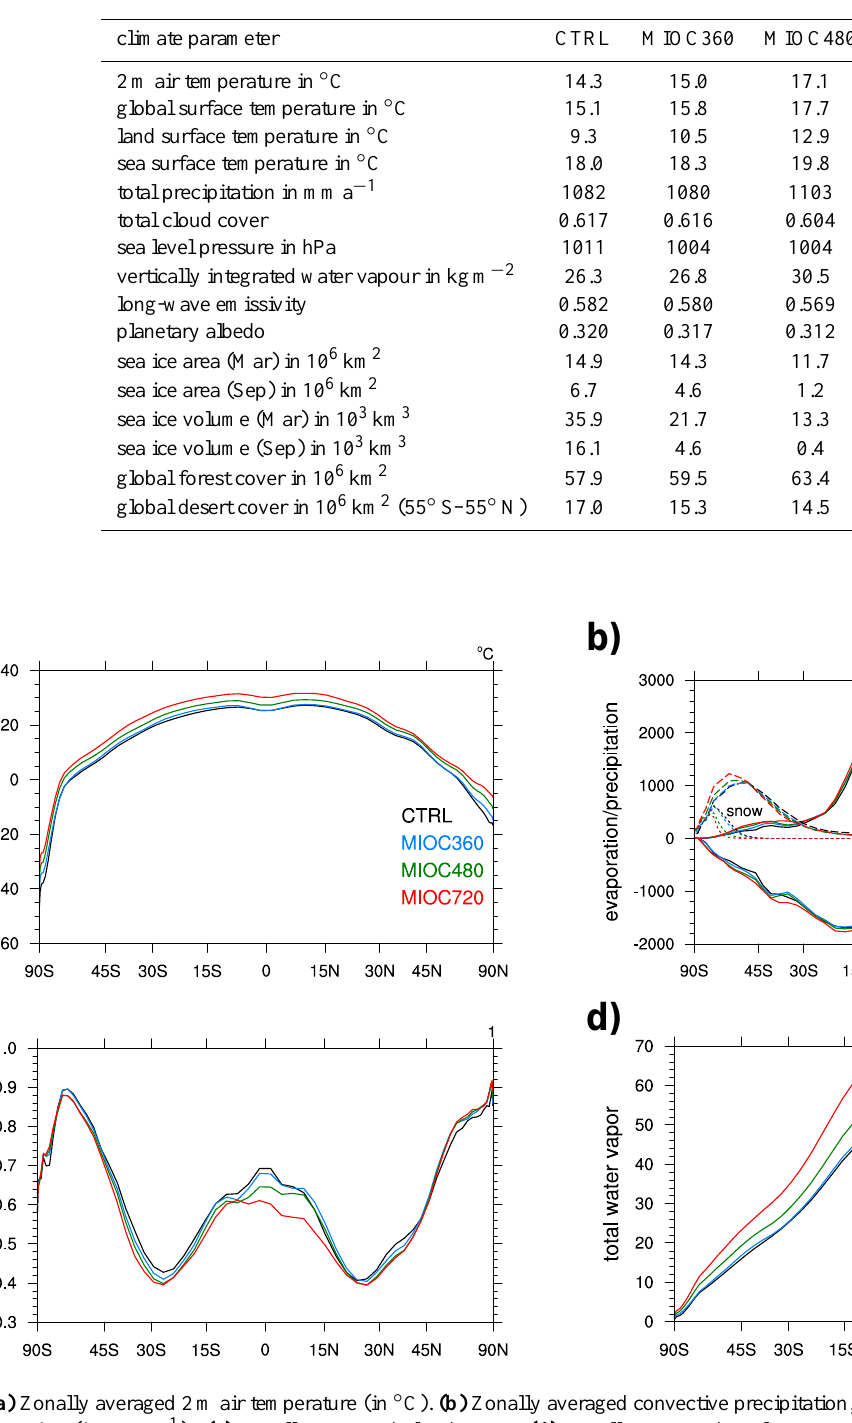
Table 2. Global mean climate parameters for all experiments. Sea ice parameters are calculated for the Northern Hemisphere.